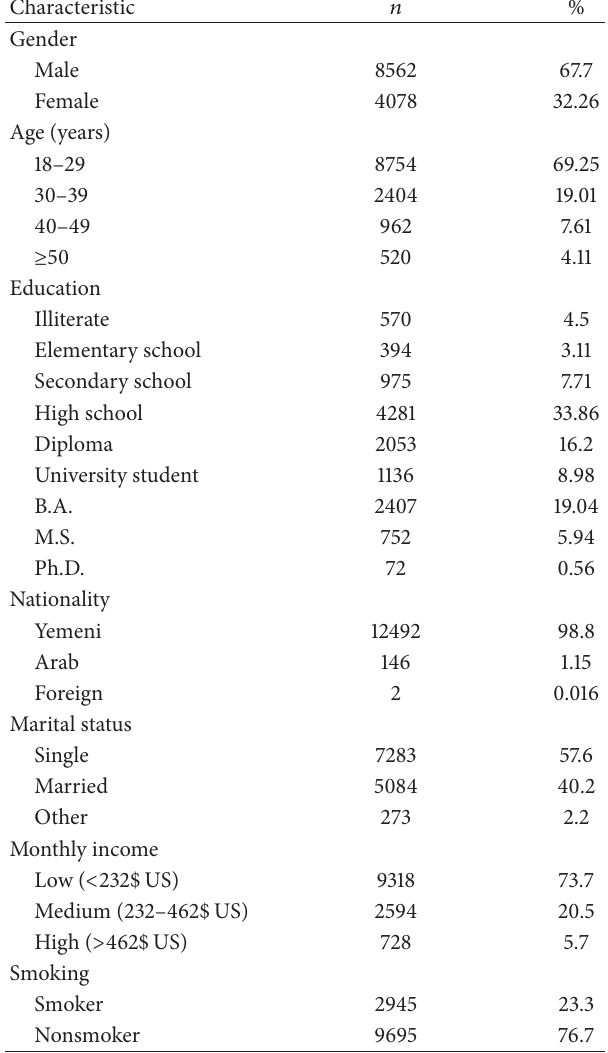
Table 1: Demographic data ( 𝑛 = 12640